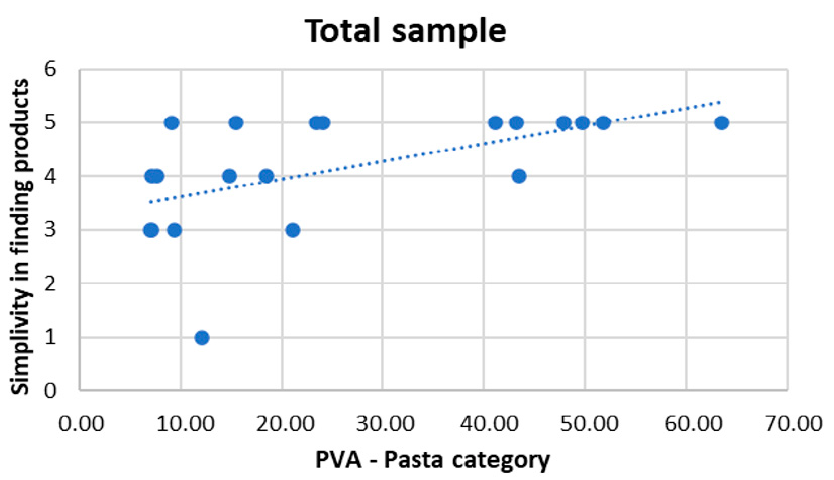
Figure 4. Correlation result: PVA and consumer experience. Significant positive correlation between simplicity in findings products and PVA in the pasta category for the entire group. No correlational value was significant in every single